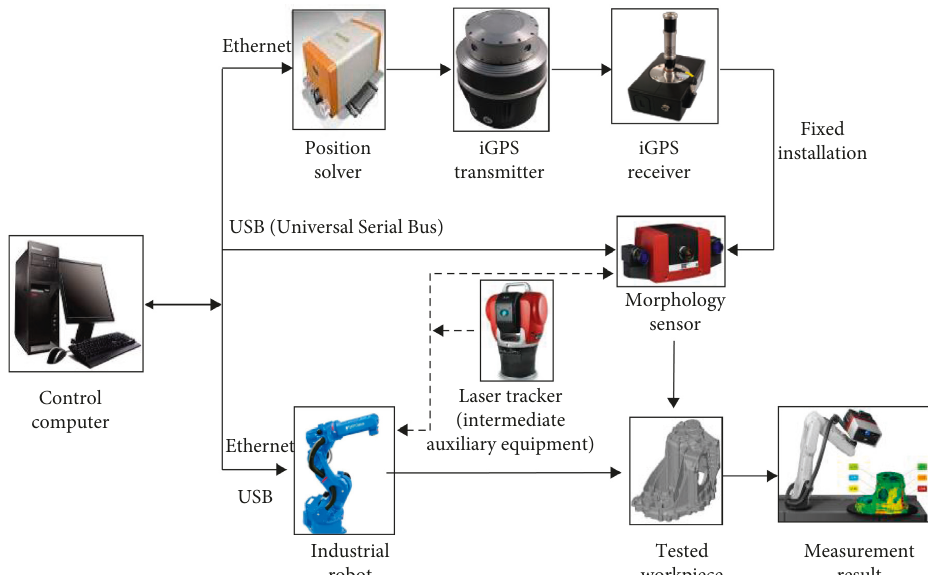
Figure 22: System plan composition block diagram.